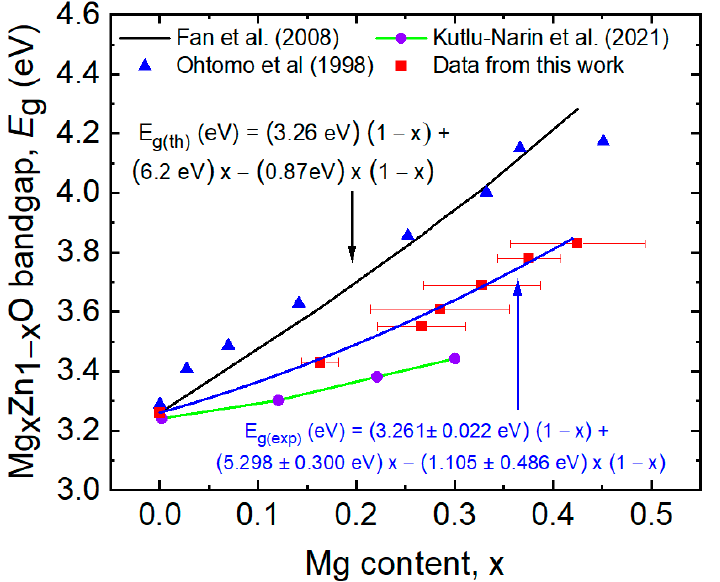
Figure 3. Bandgap of MZO thin films as determined from NIR-UV spectroscopic ellipsometry (SE) analysis plotted as a function of Mg atomic fraction as determined by energy dispersive X-ray spec- troscopy (EDS) (squares). Over this range of Mg content, the MZO films exhibit a dominant wurtzite phase. Error bars on the Mg content arise from the standard deviation of multiple measurements whereas error bars on the bandgap arise from the confidence limits in the SE analysis. The latter are in the range of ±0.001 to ±0.003 eV, smaller than the data point size. The solid blue line is the best fitting quadratic expression. Experimental data from Refs. [16] (triangles) and [40] (circles) and a theoretical result from Ref. [41] incorporating a bowing parameter (black line) are also shown.